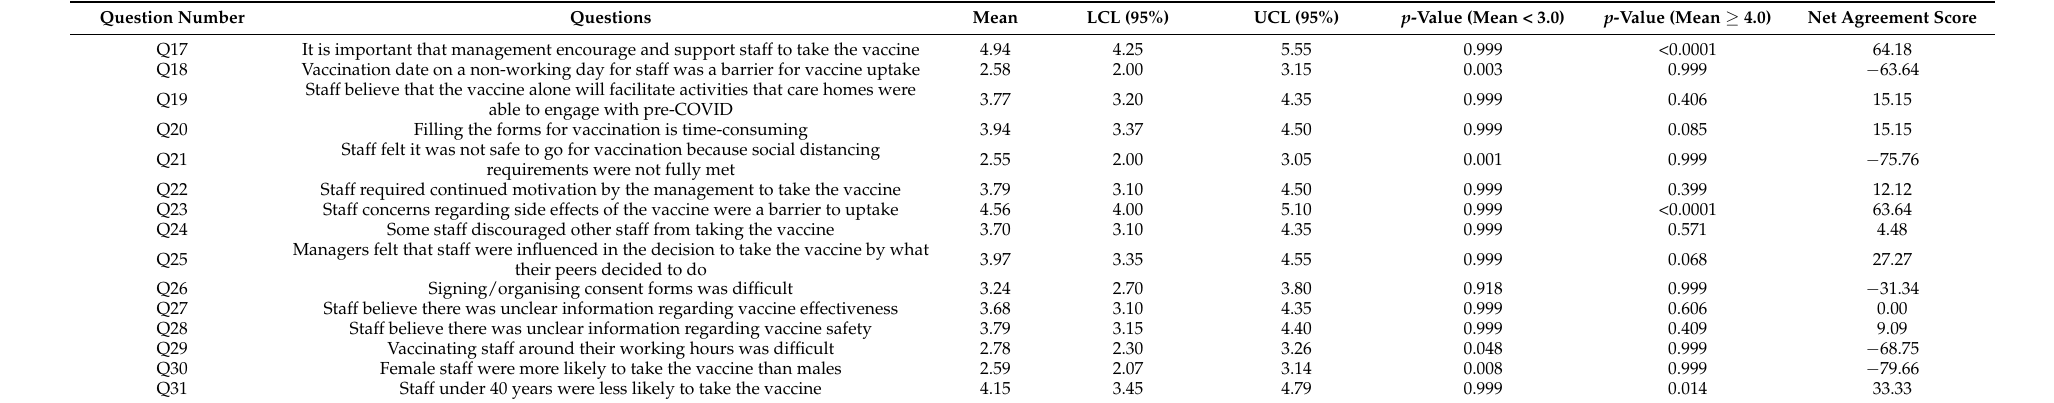
Table 4. Analyses of uptake level of COVID-19 vaccination programme in care homes by